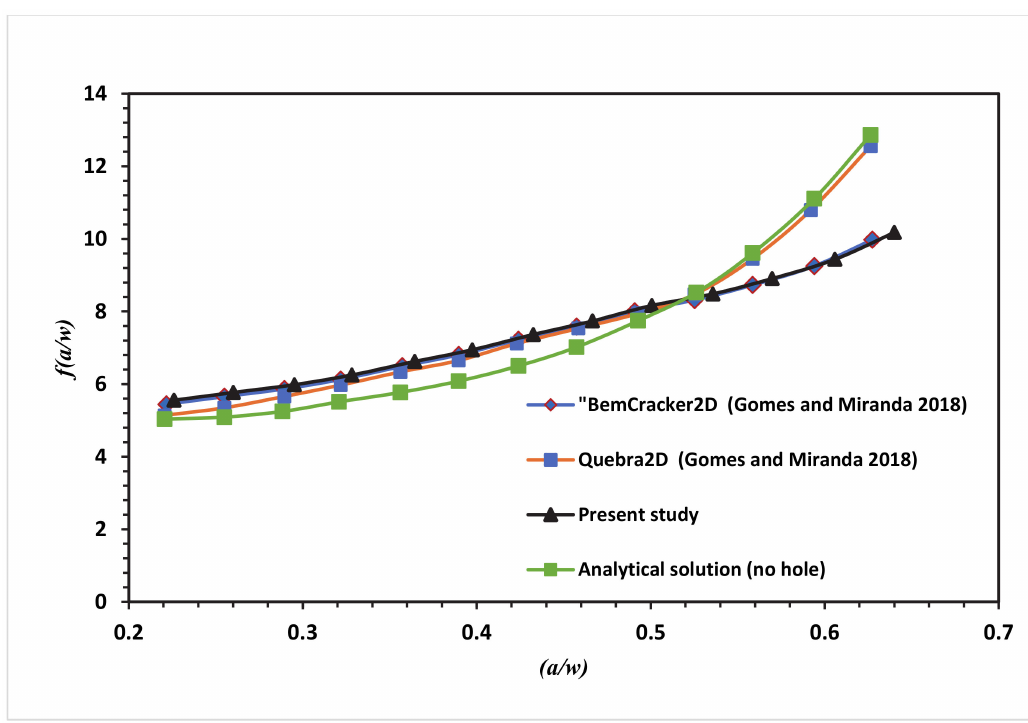
Figure 12. Dimensionless SIF of the modified compact tension specimen CTS03 compared to the work of Gomes and Miranda